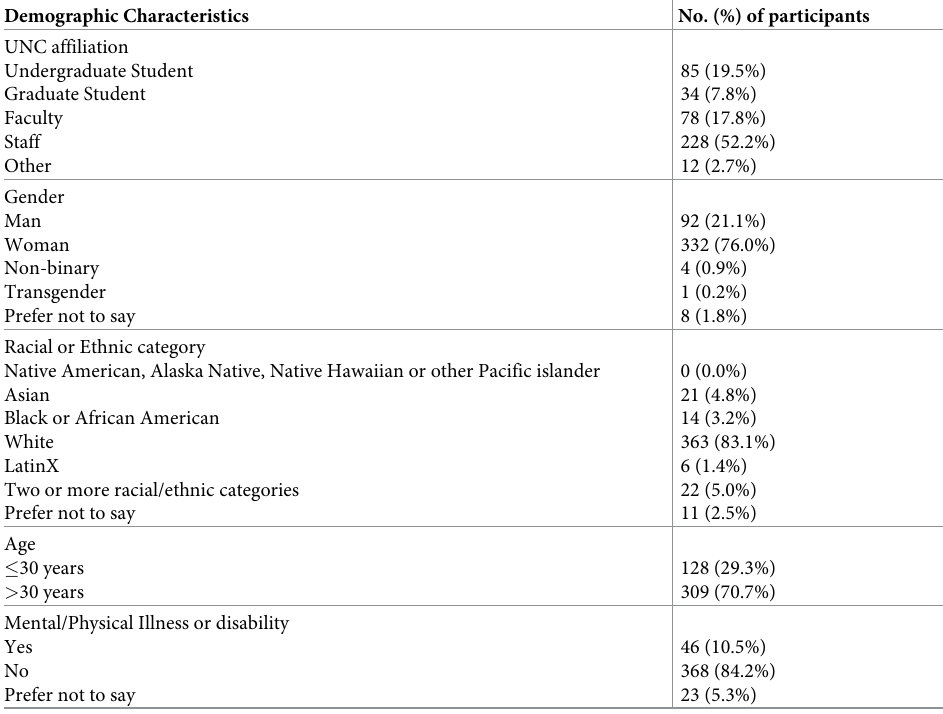
Table 2. Demographic characteristics of survey participants at UNC, 2021 (N =